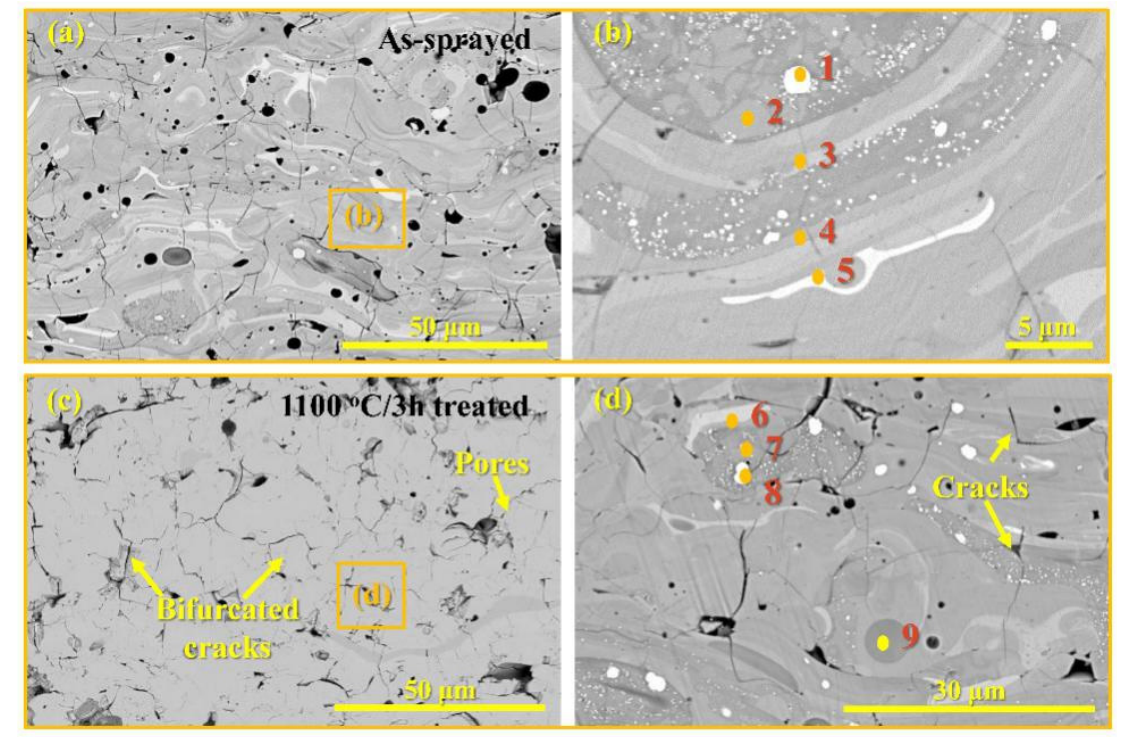
Figure 4. Cross-section morphologies of the as-sprayed ( a , b ) and thermal-aged ( c , d ) CZSO coatings. Table 4. Element contents at each point in Figure 4.